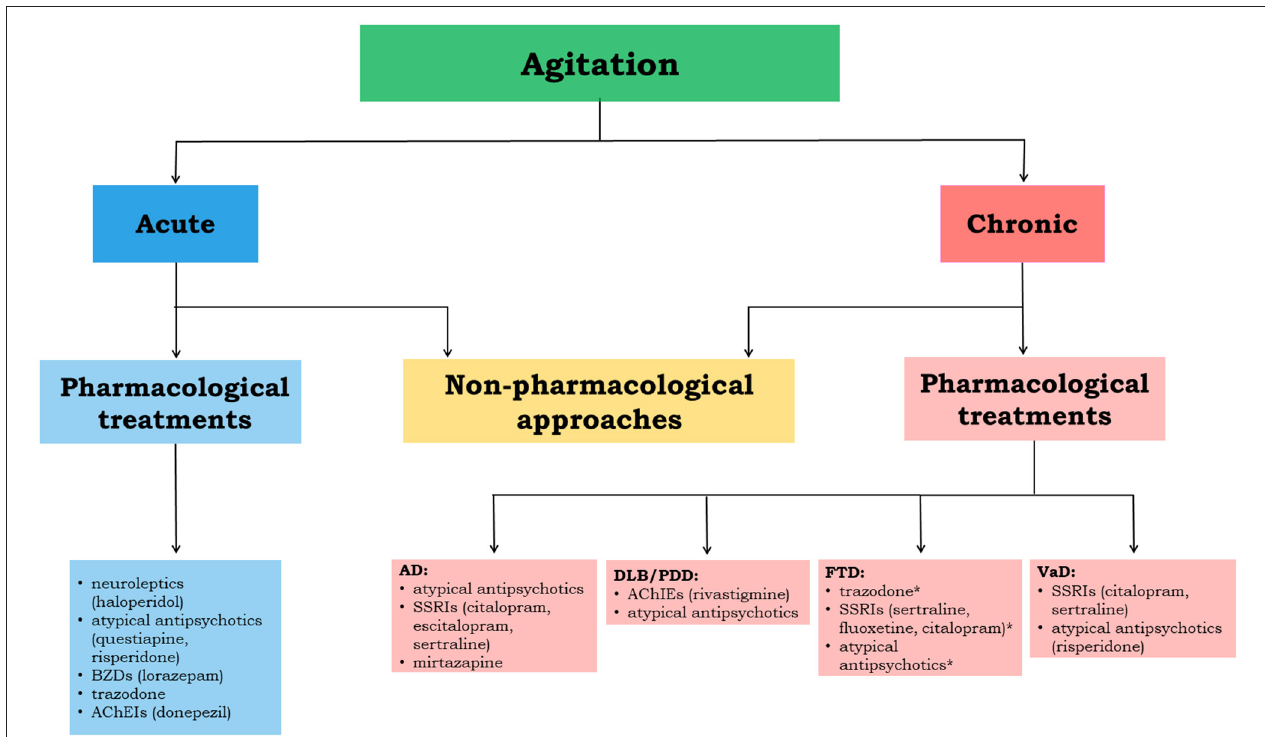
FIGURE 2 | The flowchart depicts the therapeutical management flow to be implemented in acute and chronic agitation. The most relevant evidence-based drug options are reported for each neurodegenerative disease. *indicates not sufficiently supported by clinical evidence; AD, Alzheimer’s disease; DLB, dementia with Lewy bodies; PDD, Parkinson’s disease with dementia; VaD, vascular dementia; FTD, frontotemporal dementia; AChEIs, acetylcholinesterase inhibitors; BZDs, benzodiazepines; SSRIs, selective serotonin reuptake